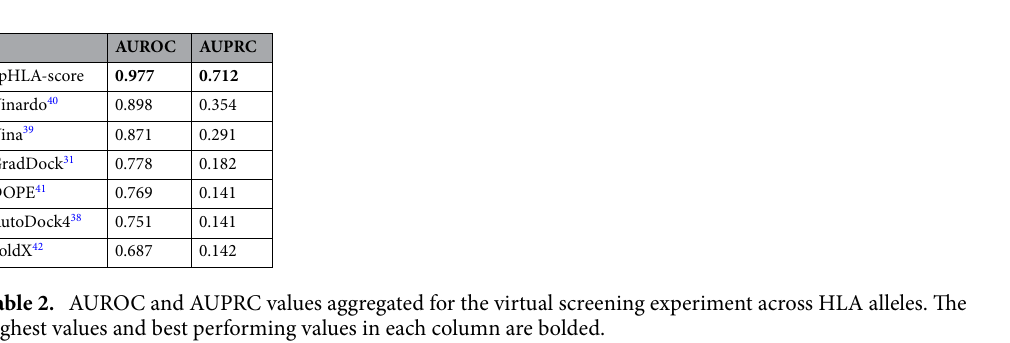
Figure 3. Results of the ablation study, in which 3pHLA-score was trained using different subsets of peptide positions: all nine positions, anchor positions (1, 2, 3, 8, 9), and middle positions (4, 5, 6, 7). Results are reported for individual alleles indicated on the x-axis. The regression power of scoring functions is quantified using Pearson’s r and plotted on the y-axis. The logo representation of the HLA-A0201 and HLA-B0801 binders is presented to compare the importance of the middle position 5 for HLA-B0801.